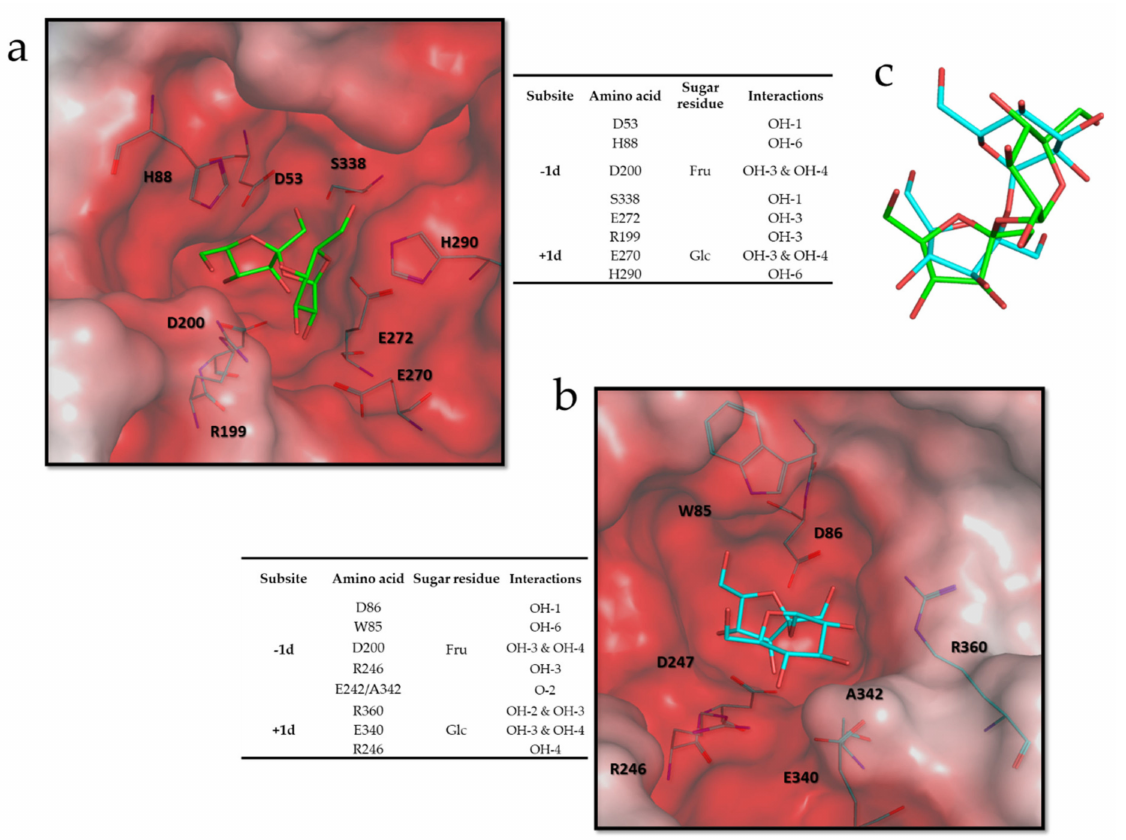
Figure 9. ( a ) Conformation of the Suc binding donor mode obtained by docking analysis with Hmc Isc. ( b ) Crystal structure of the Suc donor binding mode in B. subtilis levansucrase mutant E342A. ( c ) Overlapping of the Suc conformations in Hmc Isc model (blue) and B. subtilis levansucrase (green). The incorporated tables show the amino acid interactions as predicted by